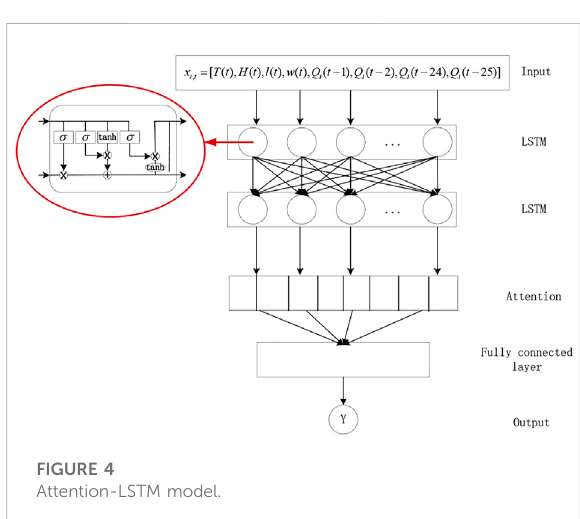
FIGURE 4 Attention-LSTM